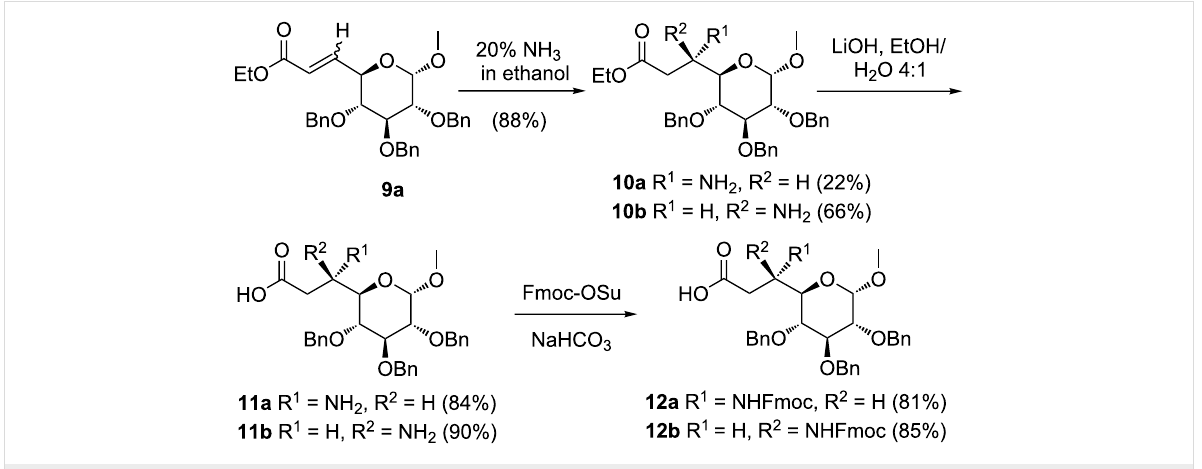
Scheme 1: Synthesis of sugar-amino acid building blocks 12a and 12b .